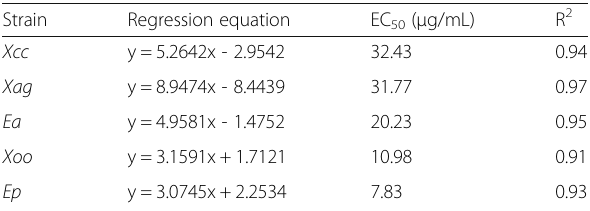
Table 1 Antibacterial toxicity of zinc thiazole against plant pathogens